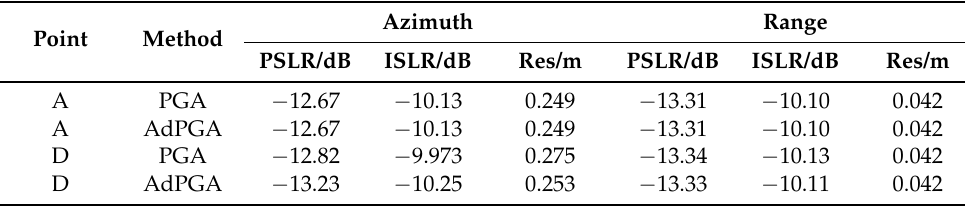
Figure 14. Comparison results of signal s 9 with the proposed aperture-dependent and traditional PGA. ( a ) Point A with traditional PGA. ( b ) Point A with proposed PGA. ( c ) Point D with traditional PGA. ( d ) Point D with proposed PGA. Table 6. Point Target Analysis of PGA Simulation with Signal s 9 .